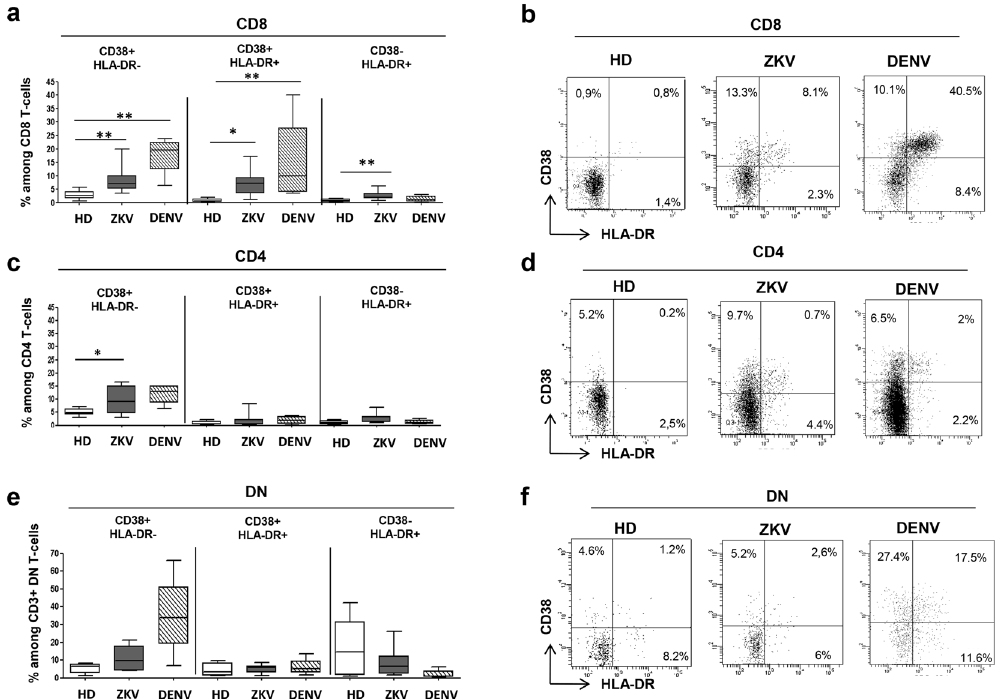
Figure 2. Activation of CD8, CD4 and DN T-cells during ZIKV infection. The frequency of activated cells (CD38 + , CD38 + HLADR + , HLADR + ) within CD8 + ( a ), CD4 + ( b ) and DN ( c ) T-cells was analyzed by flow cytometry in HD (white bars), ZIKV (grey bars) and in DENV (hatched bars). * p < 0.05; ** p <